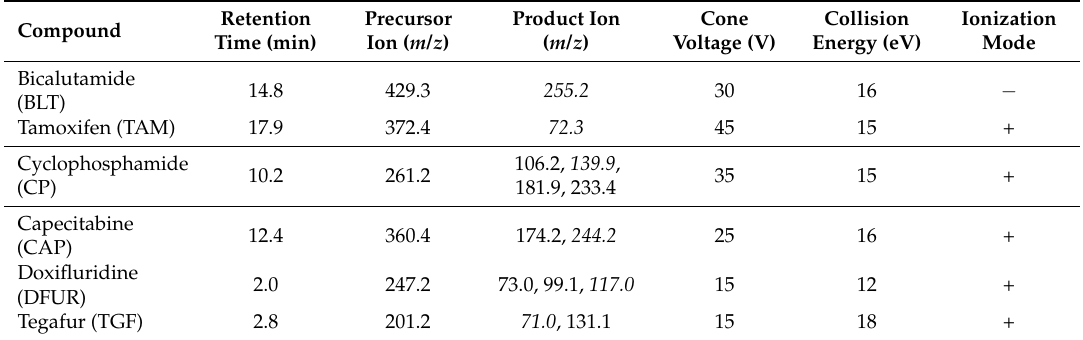
Table 4. LC-MS/MS parameters for the target anticancer drugs (reproduced from [30]). Retention Compound Time